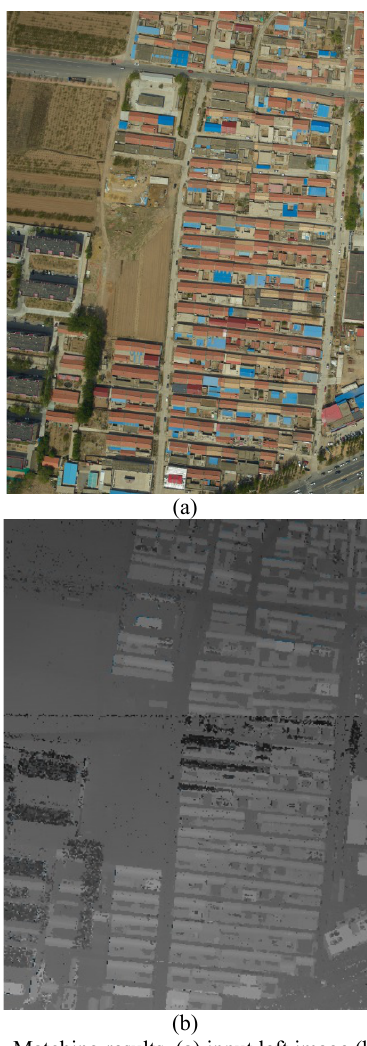
Figure 2. Matching results, (a) input left image,(b) output disparity map